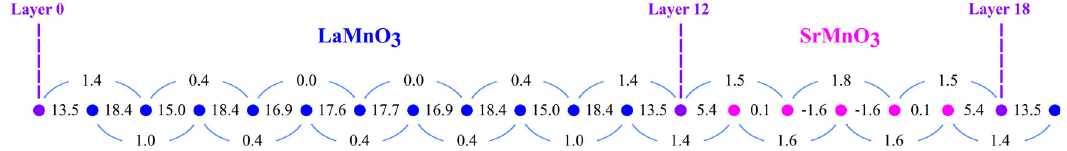
Fig. 4 Magnetic coupling constants as computed and shown along the (001) – or any of the equivalent (010) and (100) – crystallographic directions of the superlattice. The Mn are shown as circles, and the values of the coupling constants are reported in meV. Straight segments denote fi rst nearest neighbours, whereas semicircles denote fourth-nearest neighbours, namely Mn two layers away but along the same Mn- O-Mn direction (whereas they vanish for all other Mn couples).